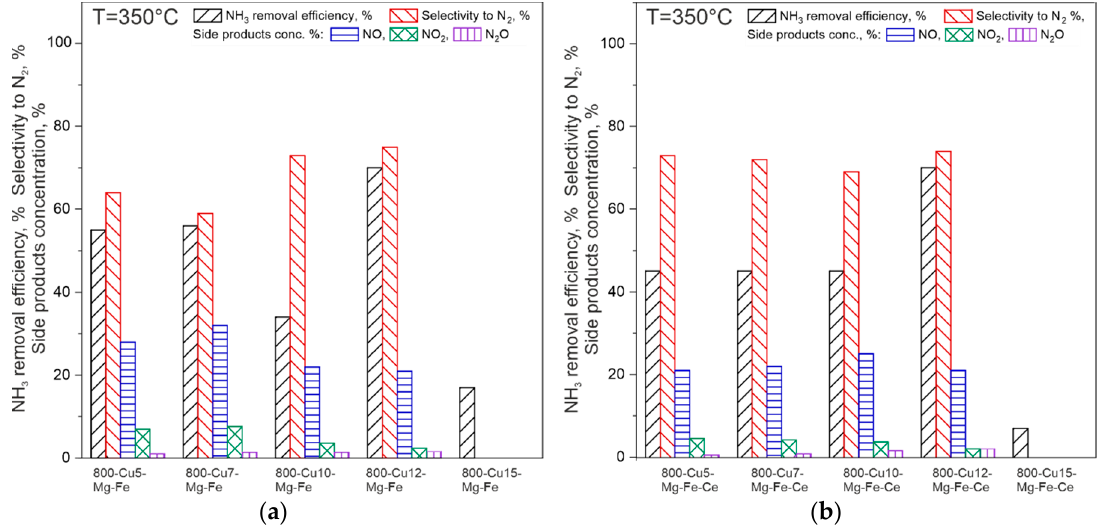
Figure 8. Results of selective catalytic oxidation of ammonia to dinitrogen at 350 °C over ( a ) 800-Cu-Mg-Fe-O catalysts; ( b ) 800-Cu-Mg-Fe-O-Ce catalysts.